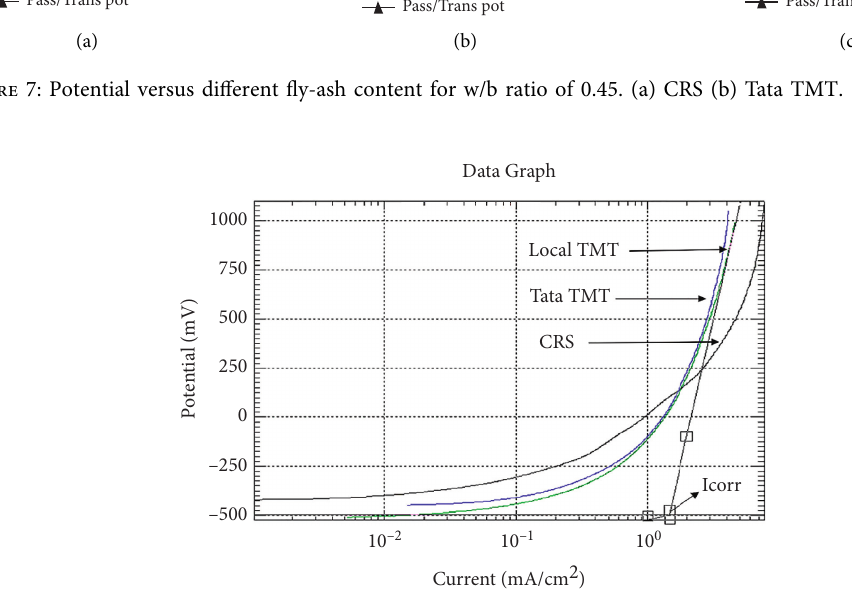
Figure 8: Anodic polarization curve of rebars in carbonated concrete powder solution and Tafel plot to obtain Icorr for F50